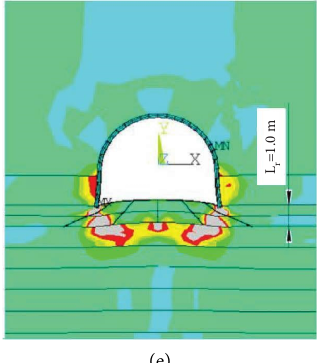
Figure 21: Total maximum principle strain distribution around the roadway after foor supporting with diferent lengths of reinforcement